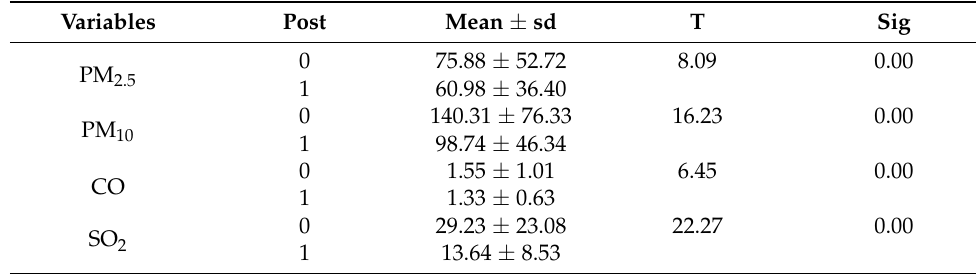
Table 4. T test results of the experimental